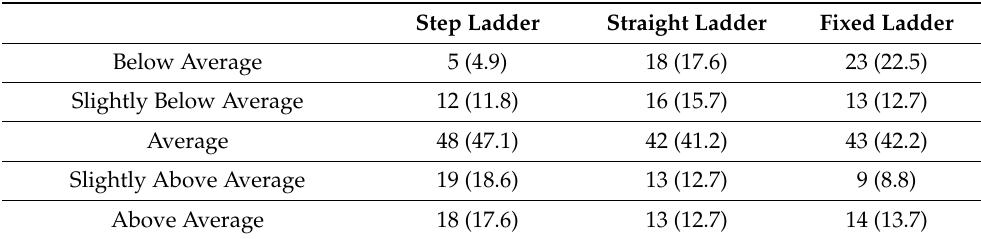
Table 1. Participants’ reported ladder use ability # .